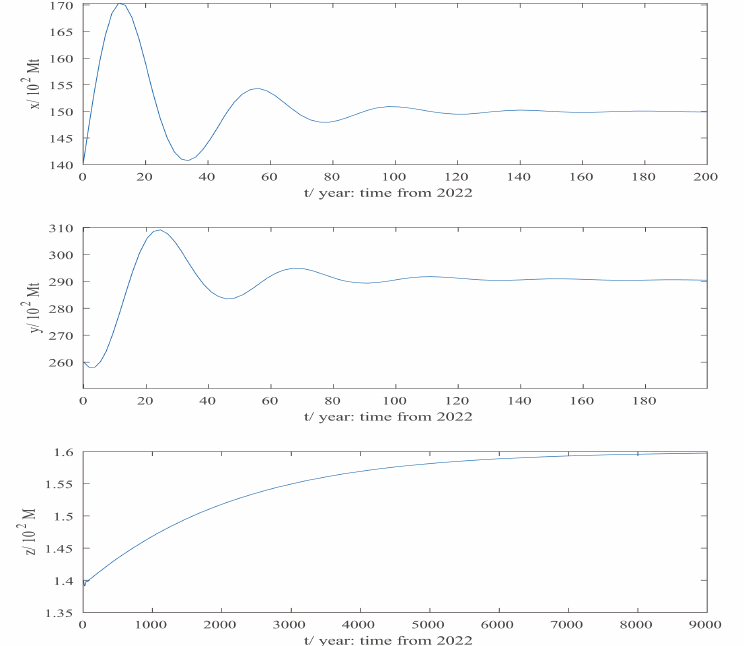
Figure 3. Equilibrium point E ∗ of system (3) is locally asymptotically stable when τ = 0 under the first group of parameters.